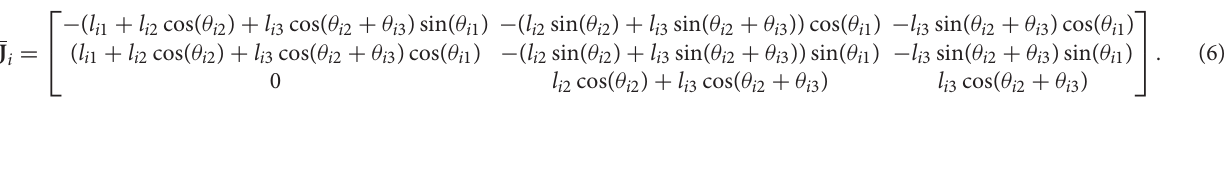
FIGURE 2 | Coordinates at different joints of each leg i . on the joints or the foot tip. l i 1 , l i 2 , l i 3 and m i 1 , m i 2 , m i 3 are the length and mass of the leg links, respectively. And θ i 1 , θ i 2 , θ i 3 are the rotational joint angles around Z i 0 , Z i 1 , Z i 2 axis of the leg.